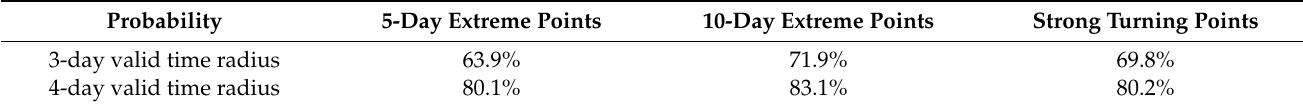
Table 5. Proportion of valid 5-day extreme points of the Second Board Index.